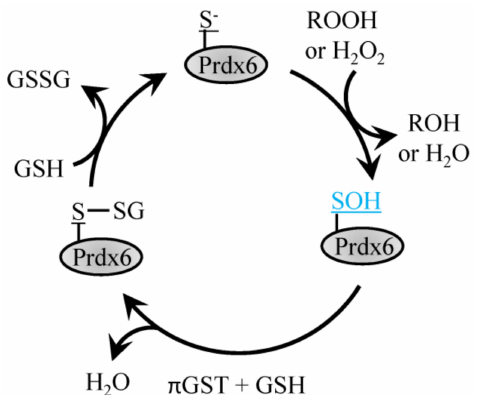
Figure 3. Reduction of H 2 O 2 by Prdx6. H 2 O 2 or ROOH recycling by 1-Cys Prdx6 involves